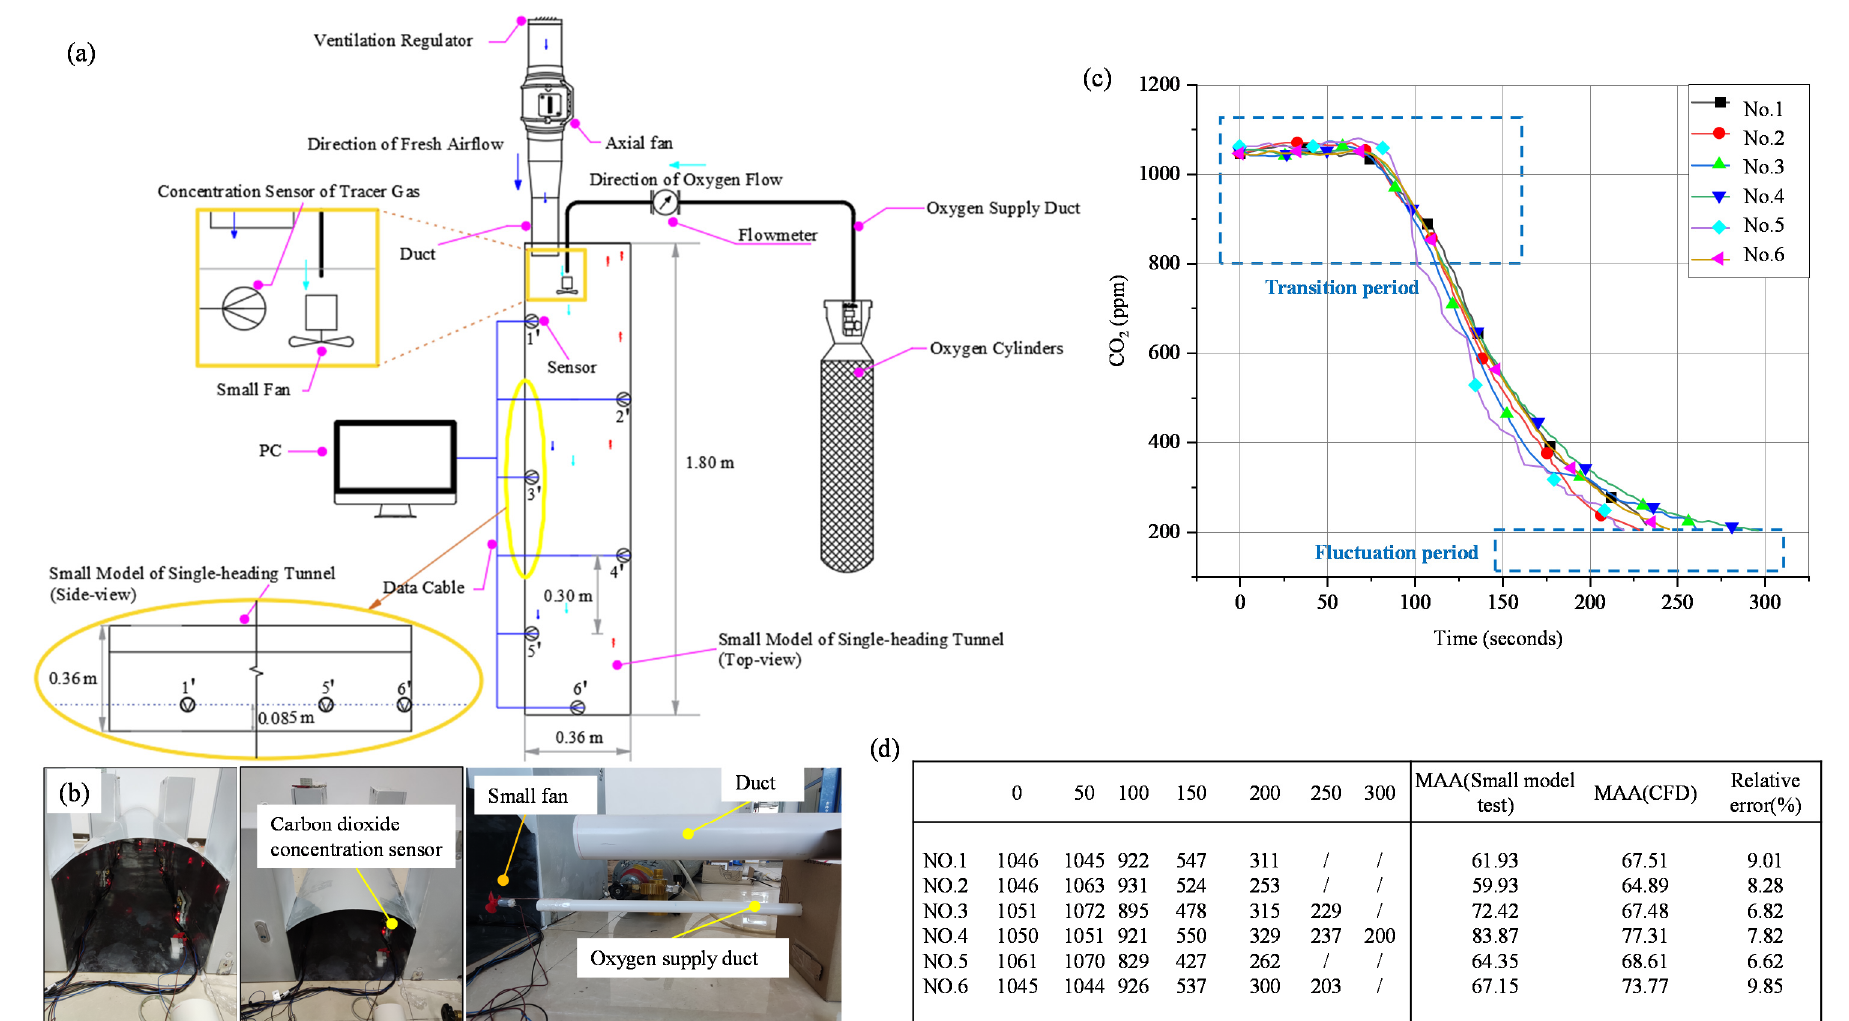
Figure 4. ( a ) The schematic diagram of the small model test; ( b ) the physical diagram of the small model test; ( c ) decay curves of CO 2 concentration at each monitoring point of the small model by experiment; ( d ) comparisons of the experiment and simulation results.